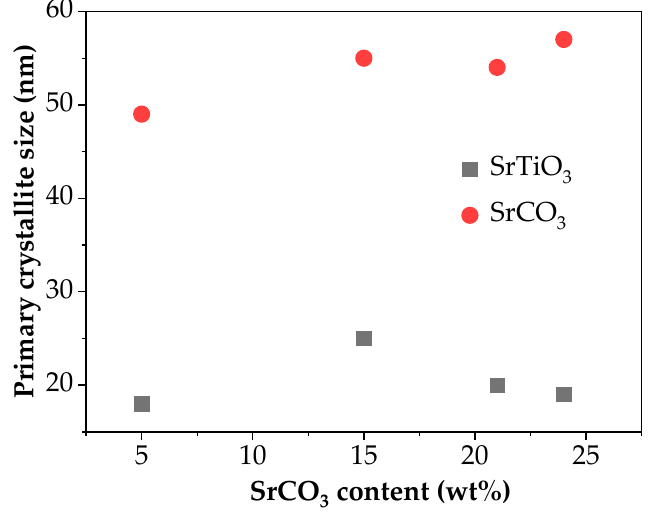
Figure 2. Primary crystallite size (PCS) vs. SrCO 3 content of the hydrothermally synthesized samples.